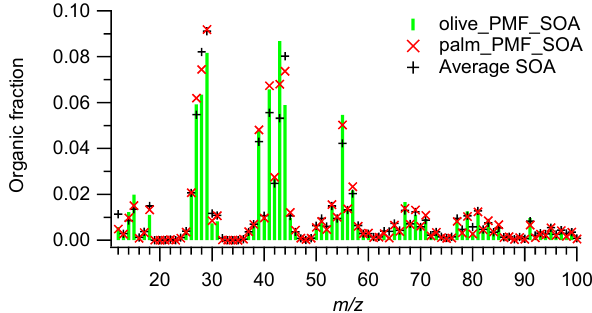
Figure 5. Mass spectra of PMF-derived SOA factors for olive and palm oil and, for comparison, the average mass spectrum of SOA formed from sunflower, peanut, corn, canola, and soybean oils. The SOA mass spectra were averaged over a 10min period after the OA concentration reached its